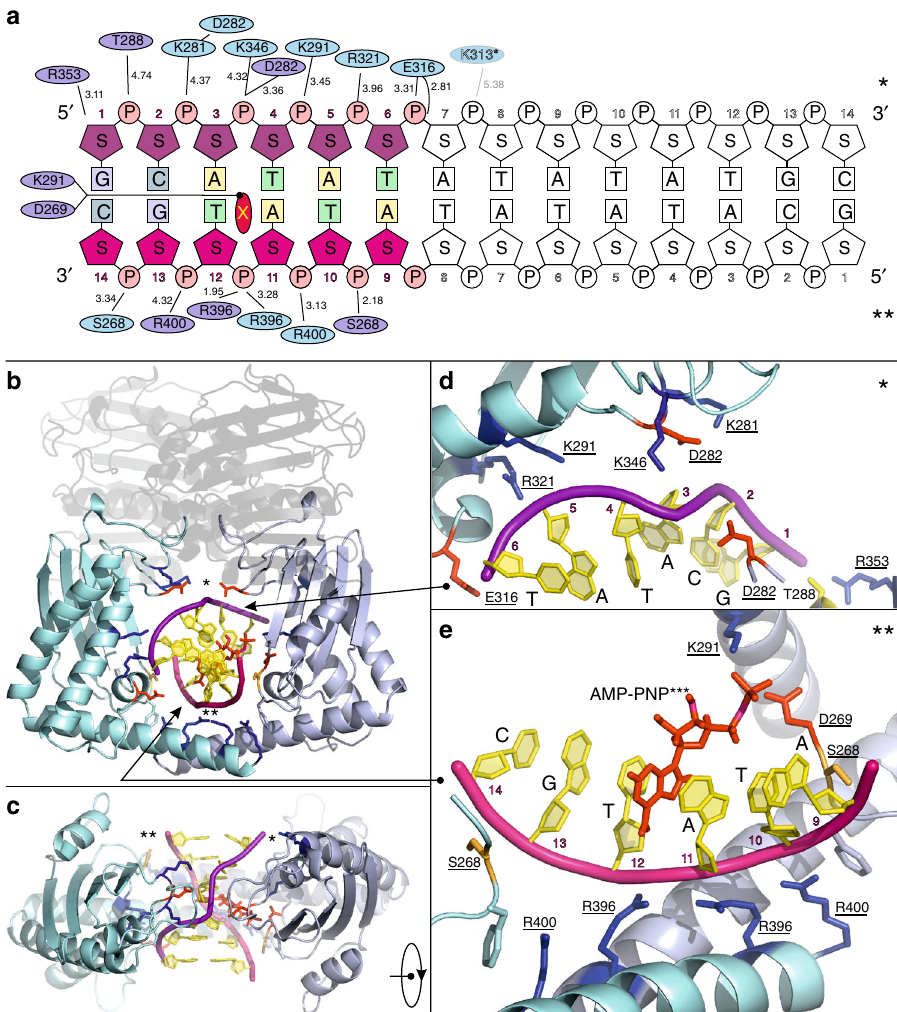
Fig. 2 Molecular features of the ParE44 complex with hole-bound 14-mer DNA. a Amino acid side chains that interact with the DNA duplex are shown as ellipses with colouring corresponding to the two subunits of the ParE dimer. Shortest distances between the DNA and the amino acid side chains are given in Ångstroms. The 6 bp DNA section that interacts with ParE is coloured, the solvent-exposed region is not. The top and bottom DNA strands are in purple and pink and are marked by single and double asterisks. X denotes a putative DNA intercalating AMP-PNP molecule shown throughout in red. The potential weakly interacting amino acid K313 is greyed. b , c Front and top views of the DNA – protein interaction, with the uninvolved N-proximal GHKL ParE region greyed out. Arrows from/to the zoom-in d , e showing the top (*) and bottom (**) DNA strand interaction sites indicate the direction of views displayed in d , e . Residues targeted for mutagenesis are